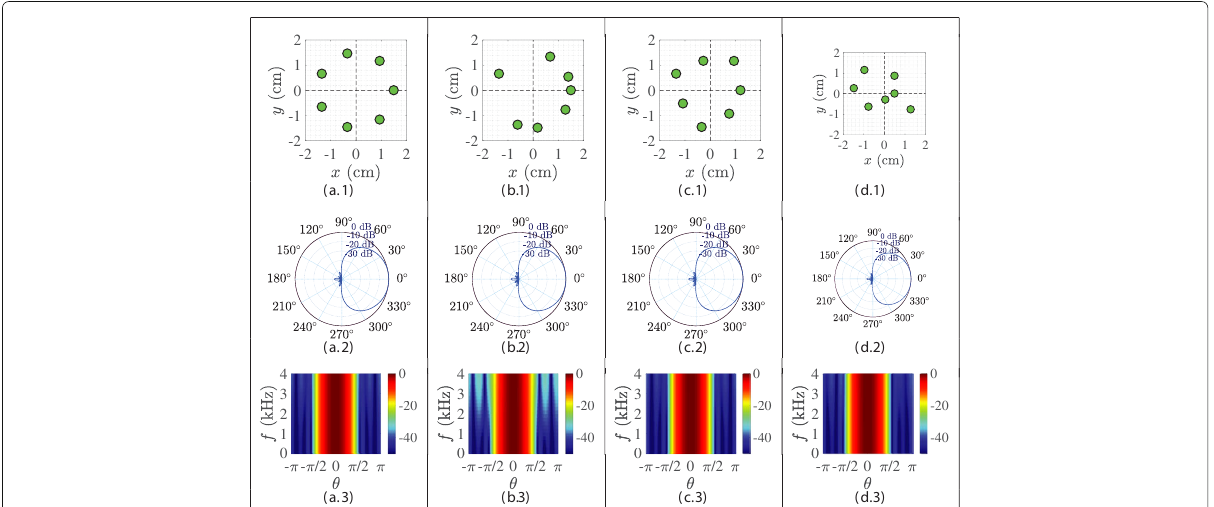
Fig.3 DI and WNG of the first-order differential beamformer designed with the algorithm in (25) with four different array geometries: a DI and b WNG